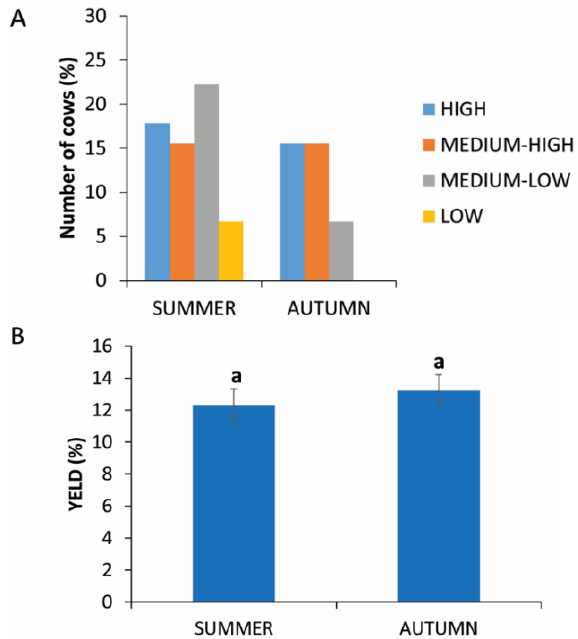
Figure 2. PRP yield in two different seasons. ( A ) Distribution (%) of cows in the different PRP yield classes in autumn or summer. ( B ) Comparison of PRP yield in autumn or in summer. Values are expressed as means and standard deviations. Different letters represent statistically significant differences.